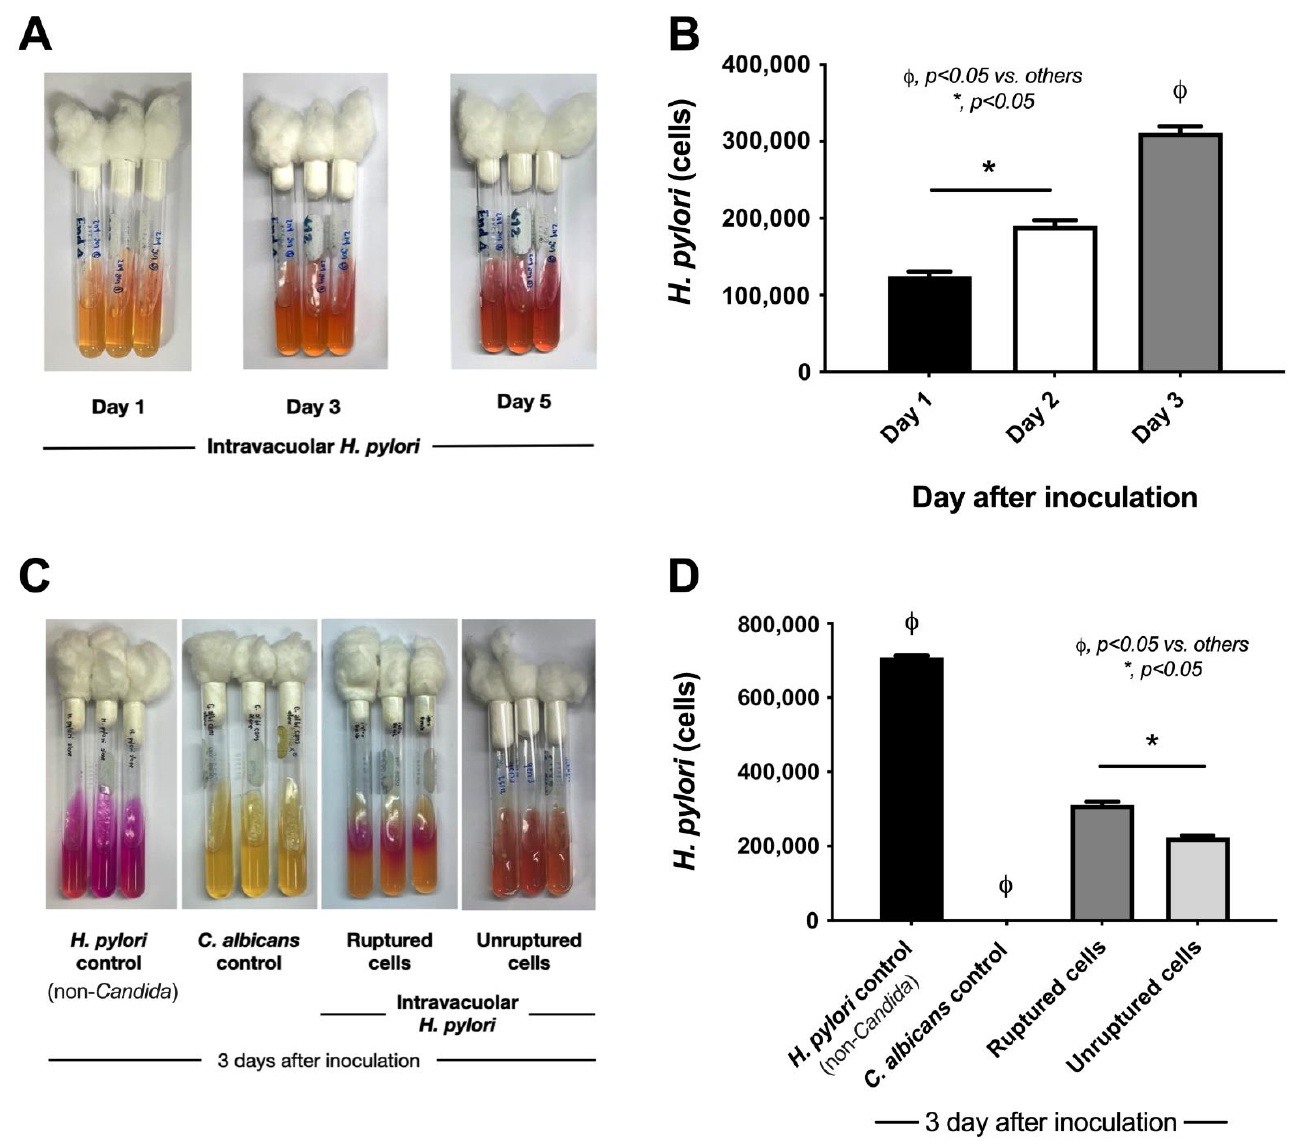
Figure 3. Characteristics of intravacuolar H. pylori released from Candida yeast cells. The activities of intravacuolar H. pylori inside C. albicans were demonstrated by culture on urea-based agar and quantitative real-time polymerase chain reaction (qPCR) after the culture (1, 3, and 5 days) ( A , B ). The results of 3 days of urea-based agar culture using sonicated samples (ruptured cells) vs. non-sonicated (unruptured cells) when compared with the H. pylori control or Candida control ( C , D ). Independent triplicate experiments were performed. *, p < 0.05; ϕ , p < 0.05 vs. others, as calculated by ANOVA with Tukey’s analysis.